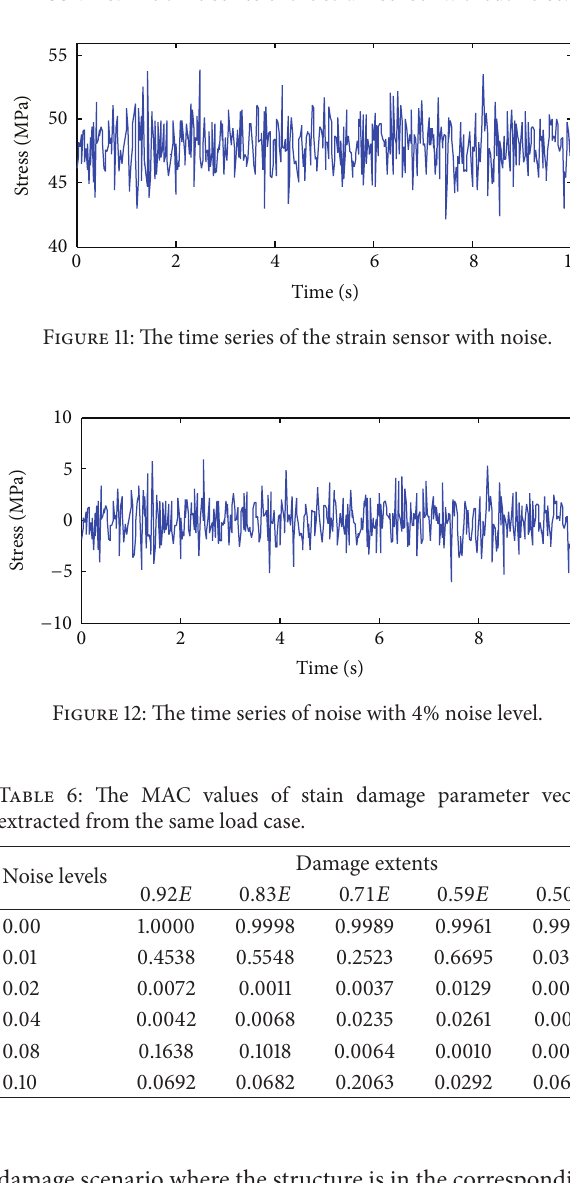
Figure 10: The time series of the strain sensor without noise.